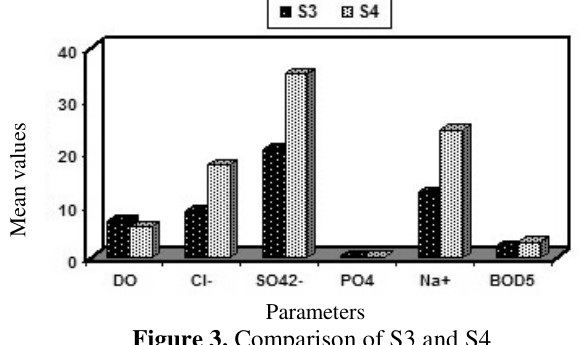
Figure 3. Comparison of S3 and